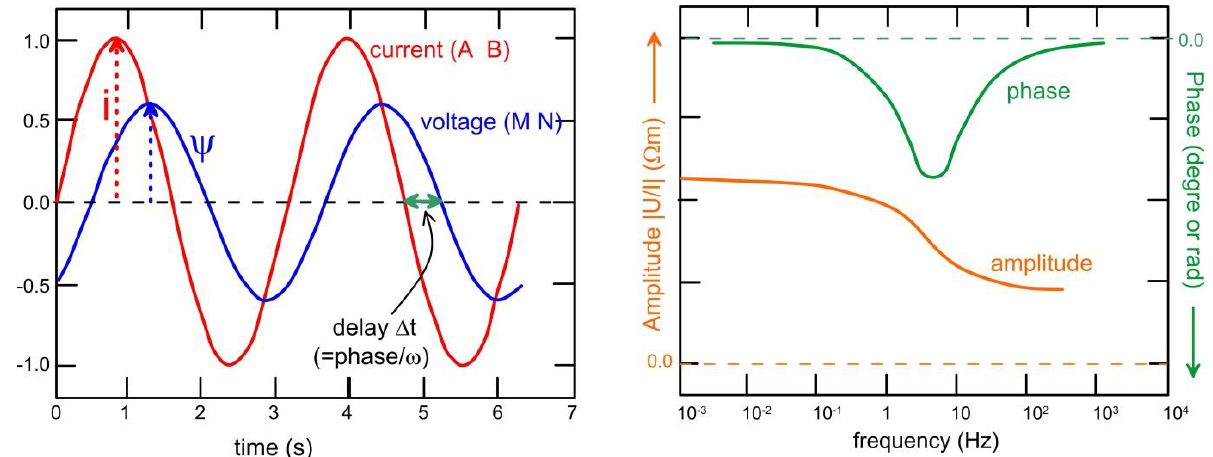
Figure 3. Spectral induced polarization (SIP) involves a set of close harmonic signals for which the amplitudes and phases are reported on a log scale (for instance: 3 points/decade). The phase is generally considered as negative. The current and the voltage are written as I and ψ , respectively. Note that the phase is related to the time lag ( ∆ t ) by Phase(rad) = ∆ t 2 π